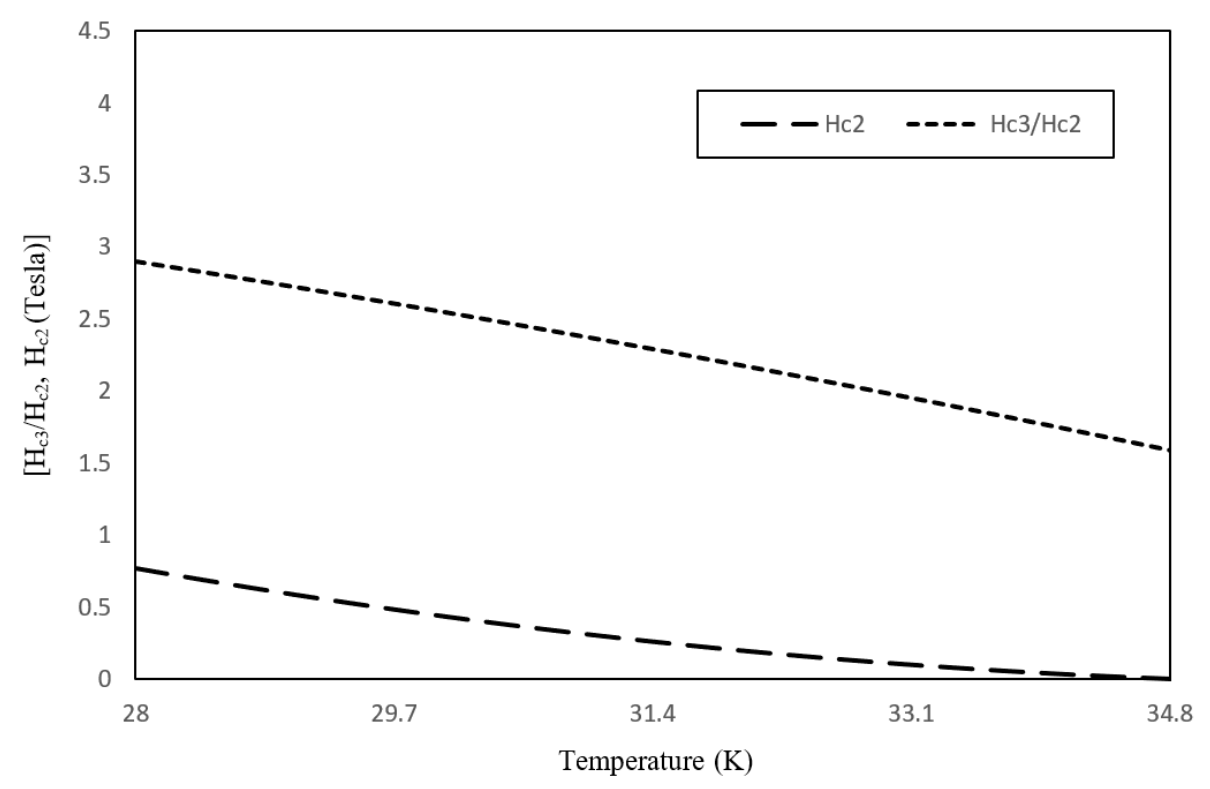
c ( T ) ( T ) versus temperature of the La Figure 5. The H c 3 and H c c 2 H c c 2 ( T ) TH c versus temperature of the La 1.85 Sr 0.15 CuO 4 -c superconduc- c 2